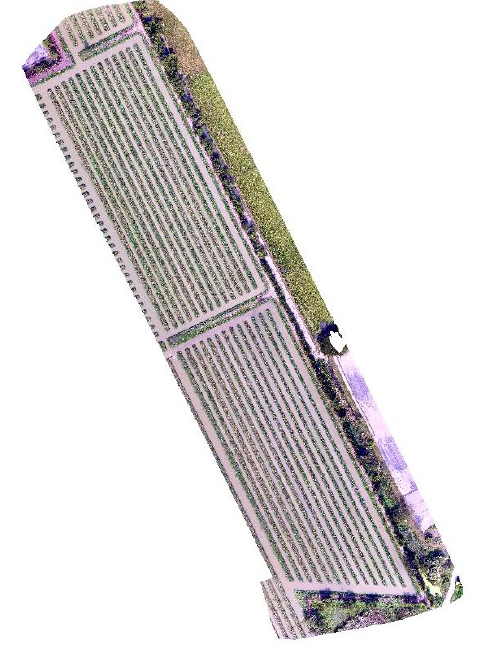
Figure 2. Orthophoto of Banana Farm